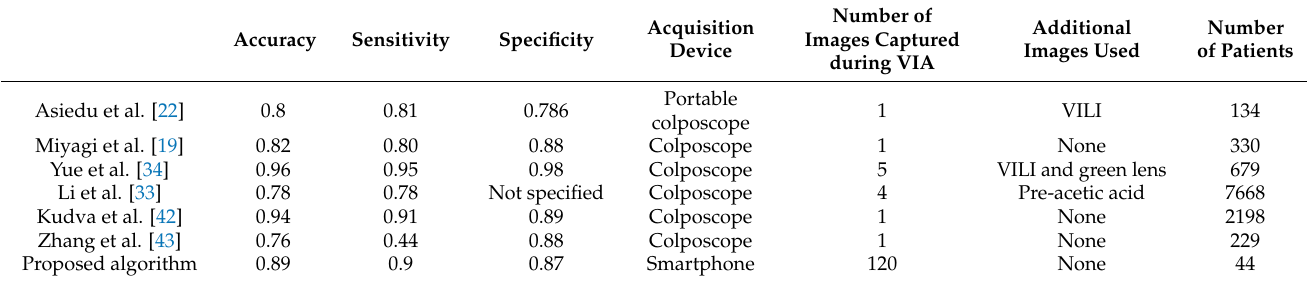
Table 5. Comparison of the proposed and state-of-the-art methods published between 2019 and 2021.